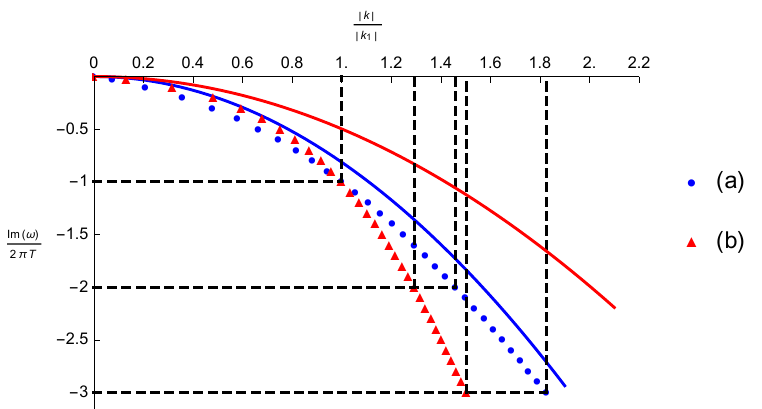
Figure 5 . Solid lines show the diffusive hydrodynamic dispersion relation (2.48). The intersections of the dashed lines correspond to the first three order pole-skipping points of Maxwell vector mode A y in the anisotropic system near Lifshitz points. Blue dots and red triangles show the curve fitting of pole-skipping points represent the data which we choose (a) θ = 9 , ζ = − 1 , z = φ = 1 ; (b) θ = 4 , ζ = − 1 , z = φ = − 1